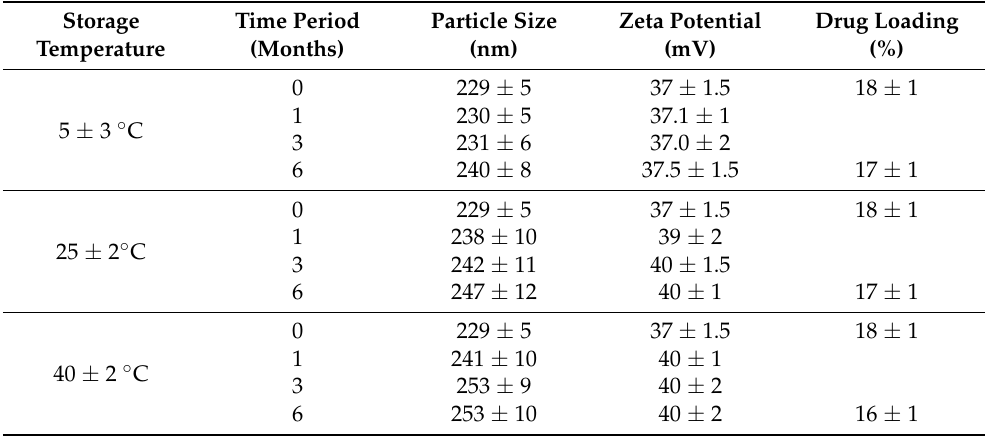
Table 2. Stability studies of TBN-CSNP at 5 ± 3 ◦ C, 25 ± 2 ◦ C and 40 ± 2 ◦ C. Each value represents the mean ± S.D ( n =